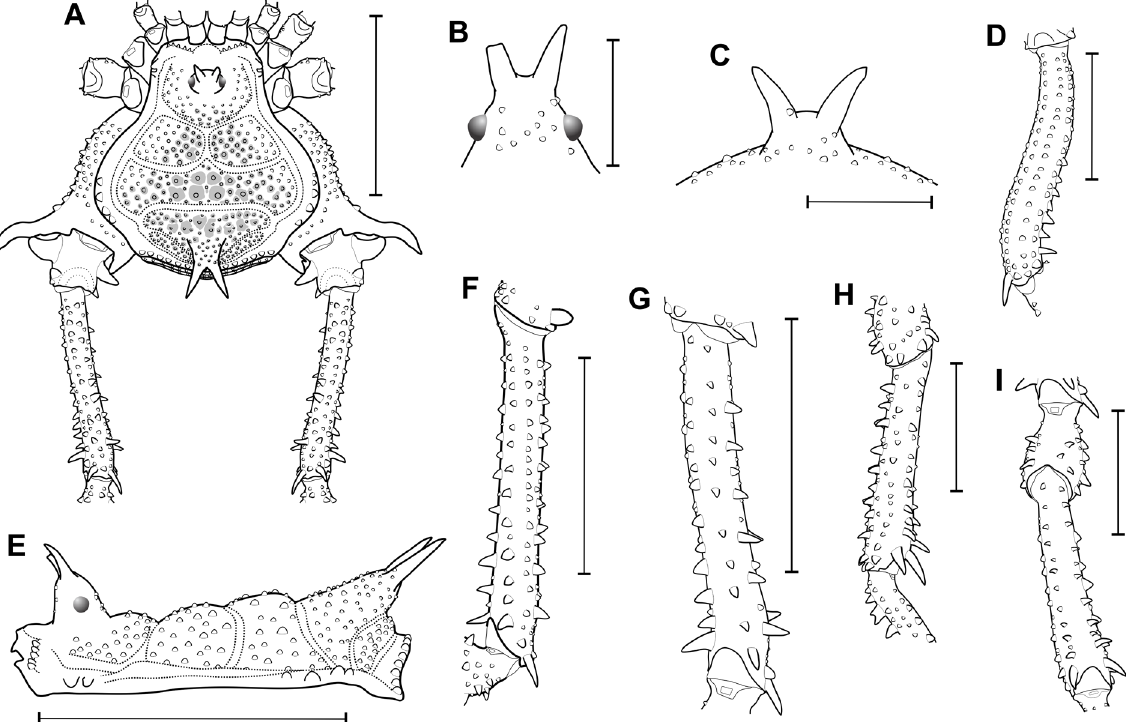
Fig. 7. Lacronia boraceae (B. Soares, 1942) comb. nov., ♂ (MNRJ-HS 122 ꜝ ). A . Habitus, dorsal view. B . Ocularium, frontal view. C . Armature of mesotergum area III, posterior view. D . Right Fe III,